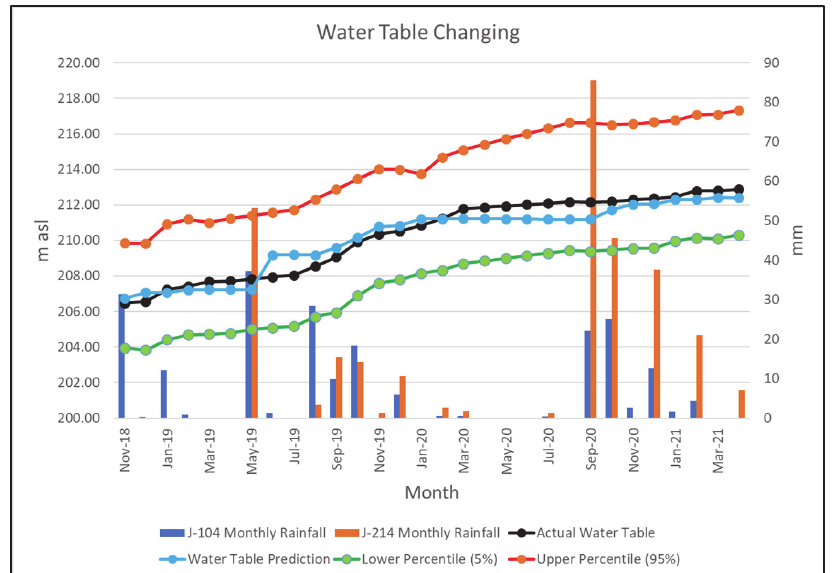
Figure 26. Monthly rainfall and water table time series as the result of transient groundwater modeling for Scenario 1 (extra recharge from neighboring watershed).